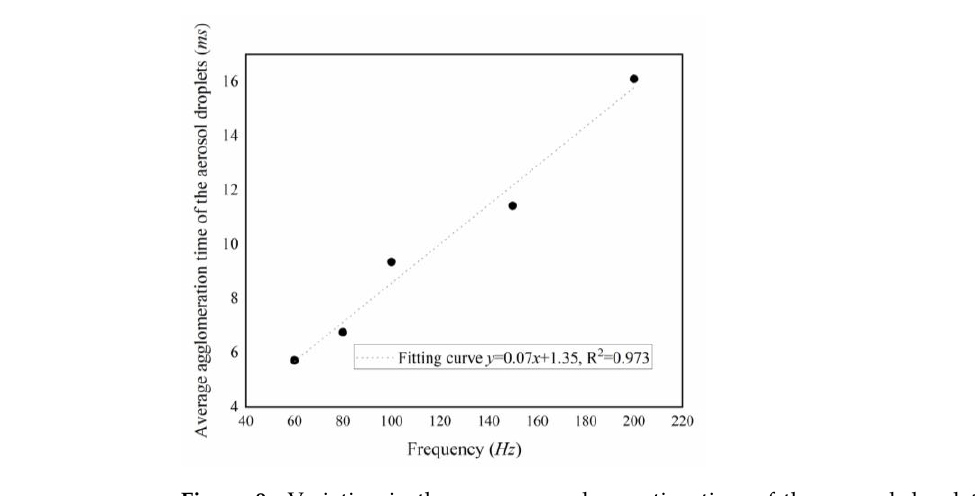
Figure 9. Variation in the average agglomeration time of the aerosol droplets with the change of frequencies.